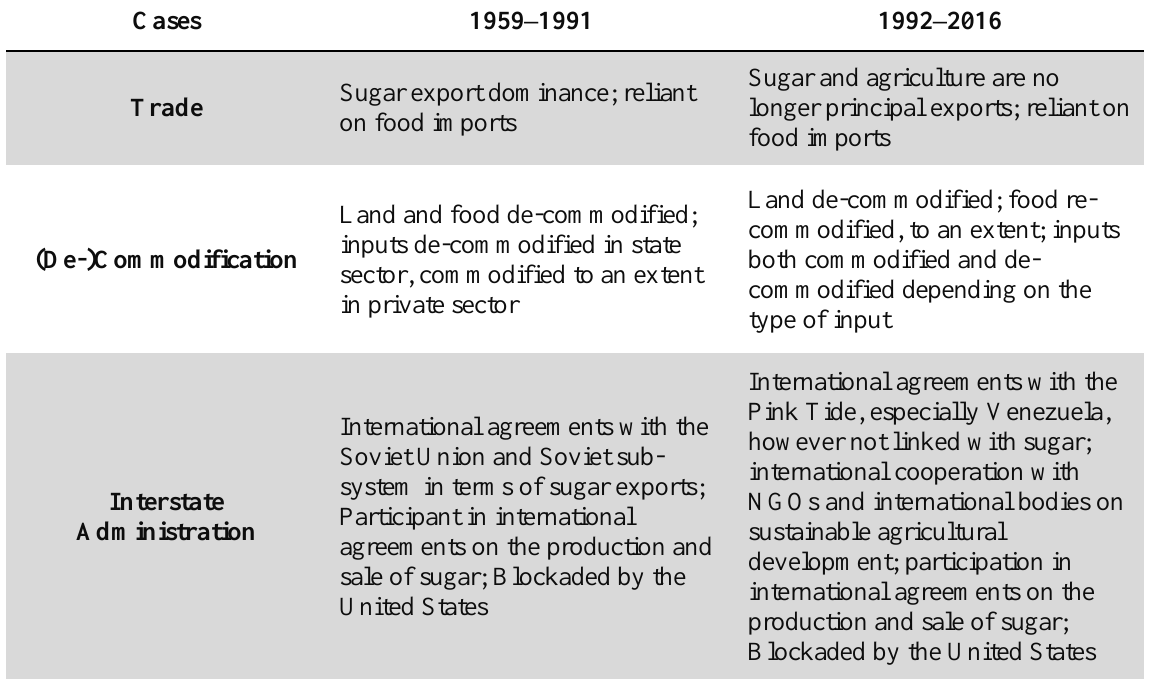
Table 3. Structural Conditions and Agricultural Production Across